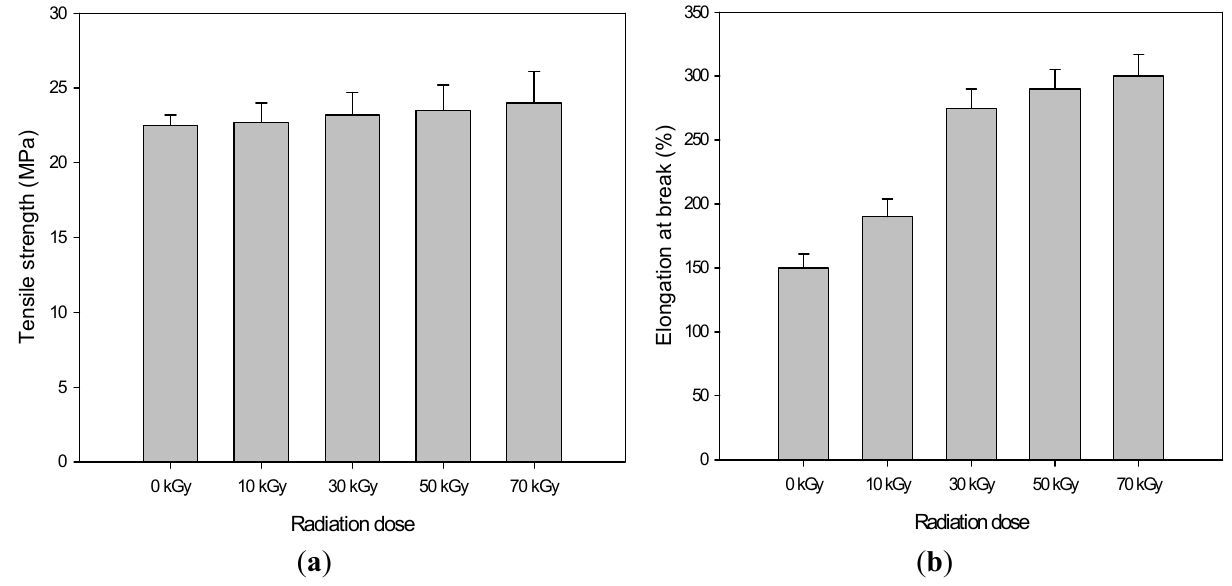
Figure 1. ( a ) Tensile strength and ( b ) elongation at break polyurethane (PU) (1 phr)/high density polyethylene (HDPE) composite at various absorption